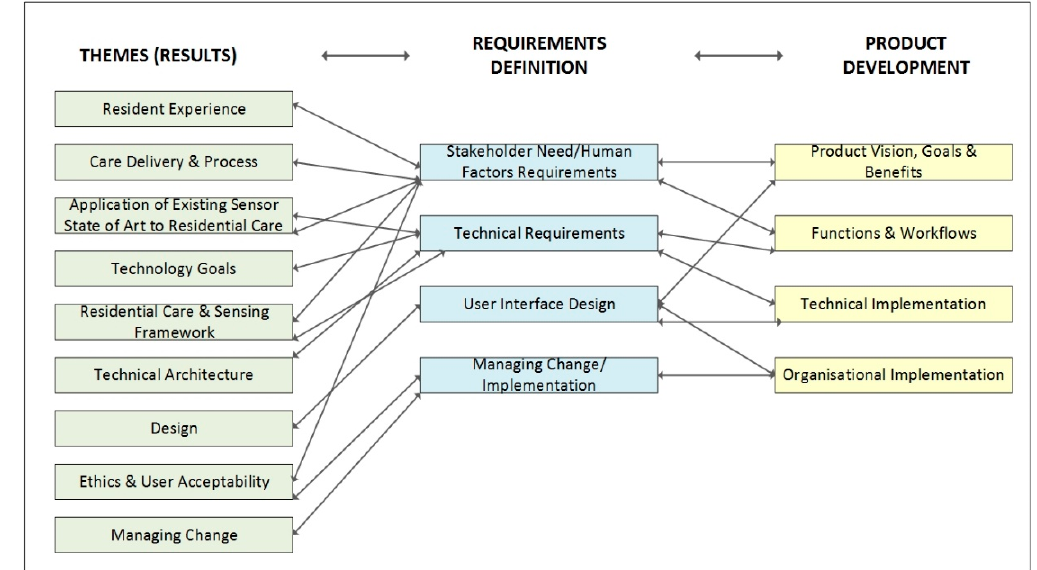
Figure 2. Themes, requirements definition and product.